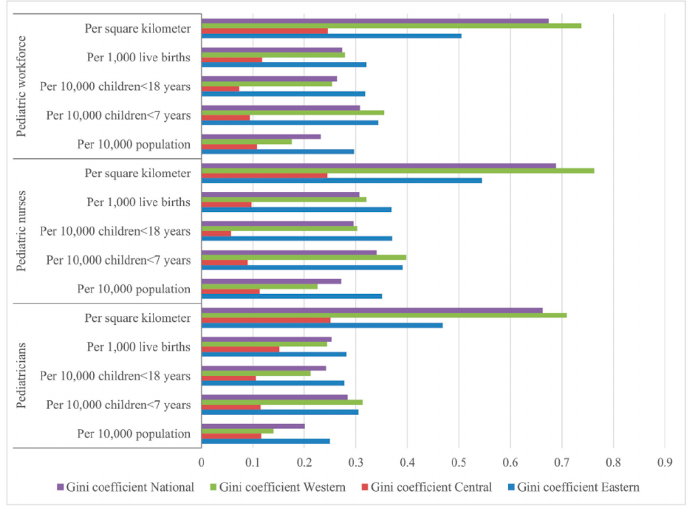
Figure 3. Comparison of Gini coefficients of different indicators at both national and regional levels.